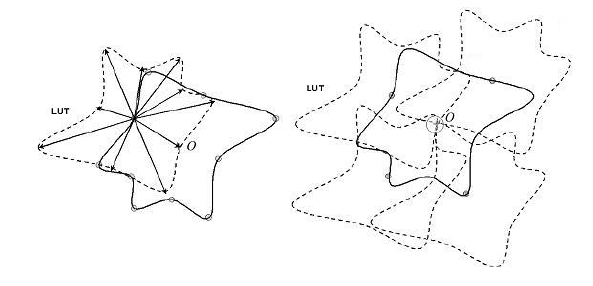
Figure 2. An example of Hough transform for lines identification. Initial image (on the left) and accumulator (or the right).